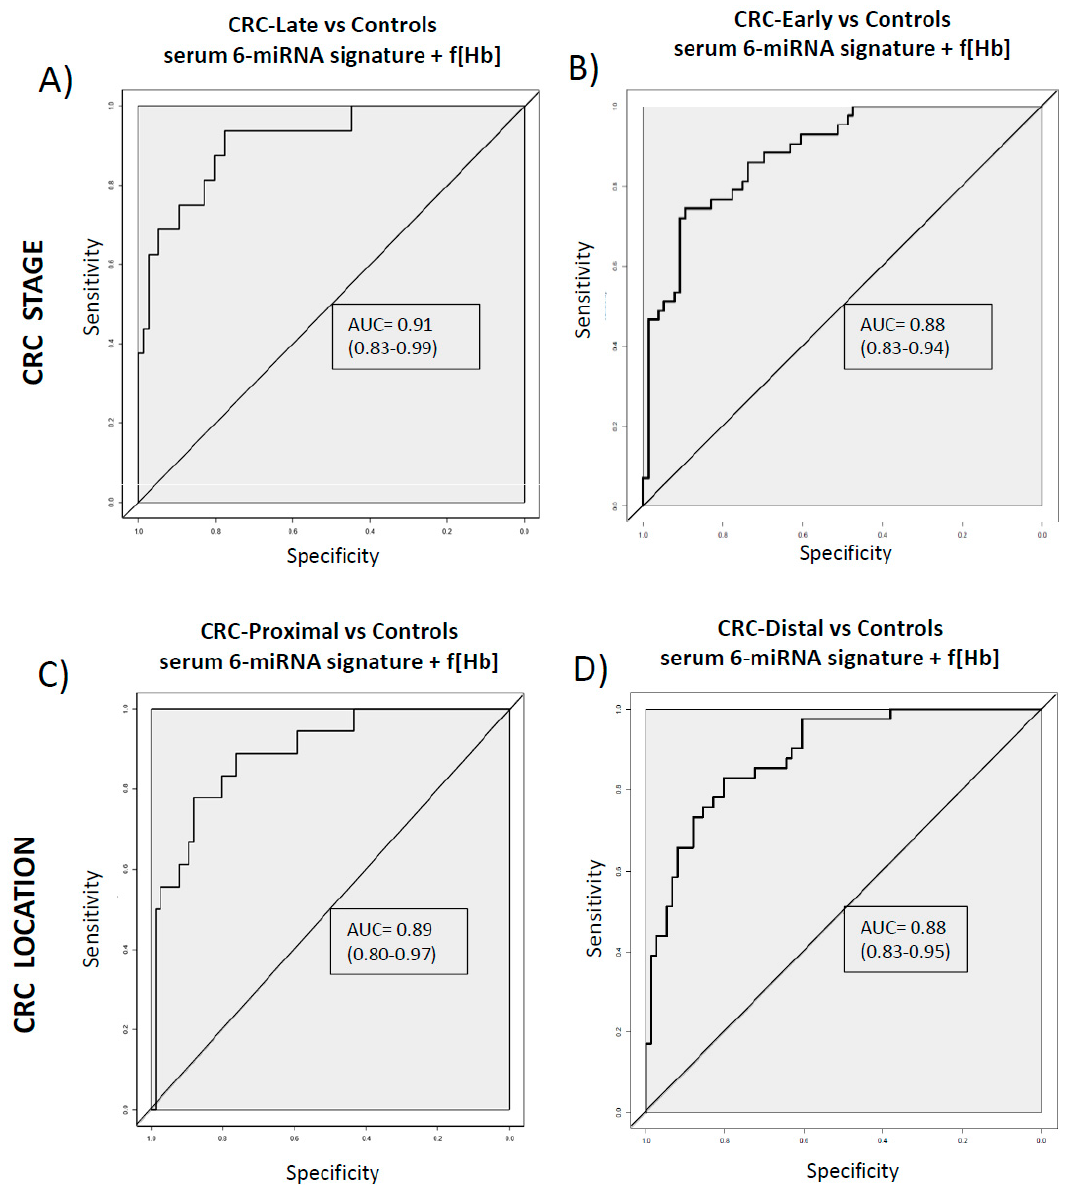
Figure 3. ROC curves of the serum 6-miRNA signature + f(Hb) adjusted by age and gender in CRC patients from different stages and different locations. ( A ) CRC Late stage (including III/IV). ( B ) CRC Early stage (including I/II). ( C ) CRC Proximal (including the ascending colon, the cecum, the right side of the colon and the transverse colon). ( D ) CRC Distal (including descending colon, left side of the colon, sigmoid colon, and the section of the colon that connects to the rectum). Colorectal cancer (CRC), controls (C), faecal haemoglobin concentration (f(Hb)).